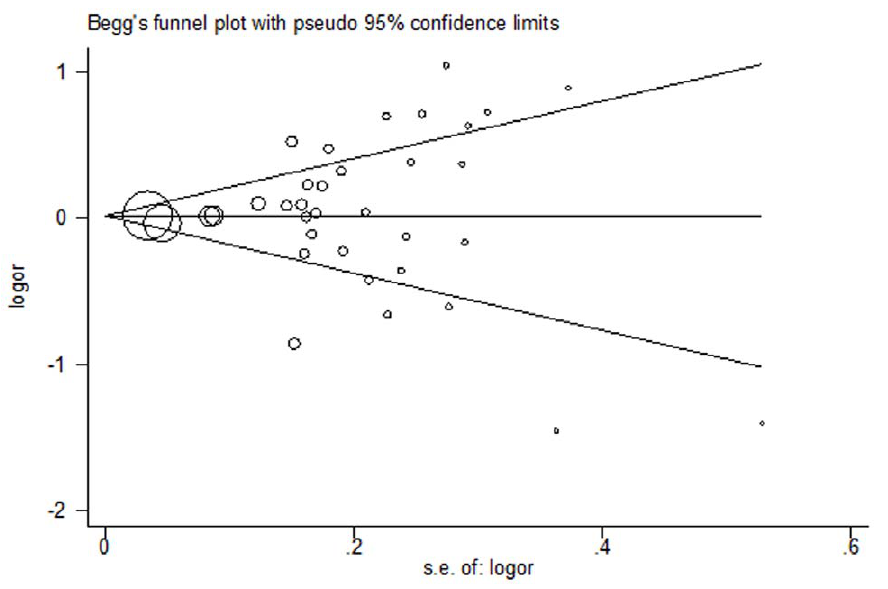
Figure 4. Begg’s funnel plot for publication bias test (dominant model). Each point represents a separate study for the indicated association. Log[or], natural logarithm of OR. Horizontal line, mean effect size.